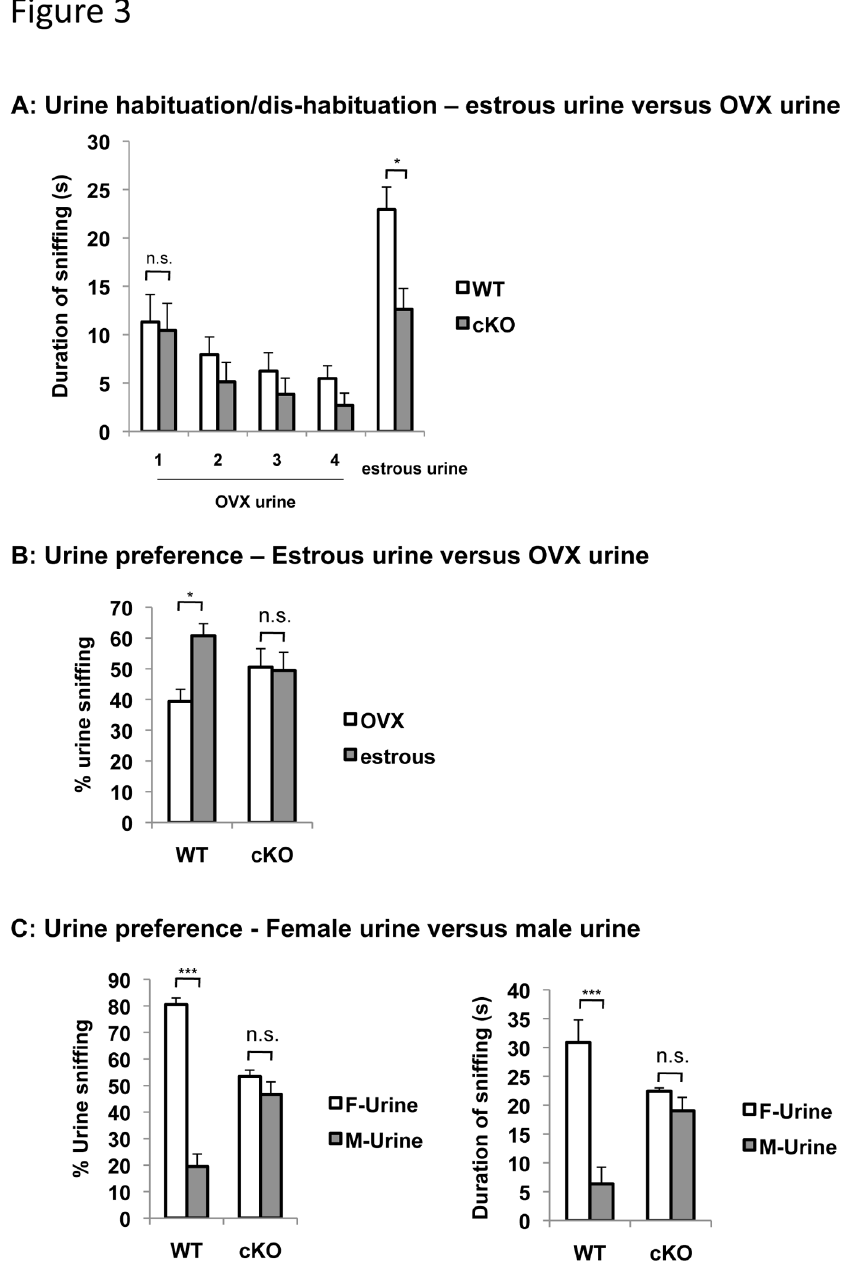
Figure 3. Conditional deletion of ERK5 impairs male mice’s preference for normal and estrous female pheromones. A , ERK5 cKO mice are able to discriminate between the ovariectomized (OVX) urine and the estrous urine, although they display reduced level of interest to the estrous urine compared with their WT littermates. Ovariectomized mice were artificially cycled with the estradiol and progesterone and the urine collected before hormone injection was used as the ovariectomized urine, while urine collected after hormone injection was used as the estrous urine. The subject mice were presented with one cotton swab laced with ovariectomized urine for 4 trials followed by one trial of the estrous urine. B , Male ERK5 cKO mice do not prefer urine from estrous females over that from ovariectomized females. Mice were presented simultaneously with two cotton swabs laced with urine samples collected and pooled from a group of ovariectomized female mice either before or after the artificial cycling with the estradiol and progesterone. C , Male ERK5 cKO mice lost their innate preference for the female urine versus male urine. Mice were presented simultaneously with two cotton swabs laced with male or female urine samples respectively. n.s., not significant; *, p<0.05; ***, p<0.001. doi: 10.1371/journal.pone.0076901.g003 PLOS ONE |